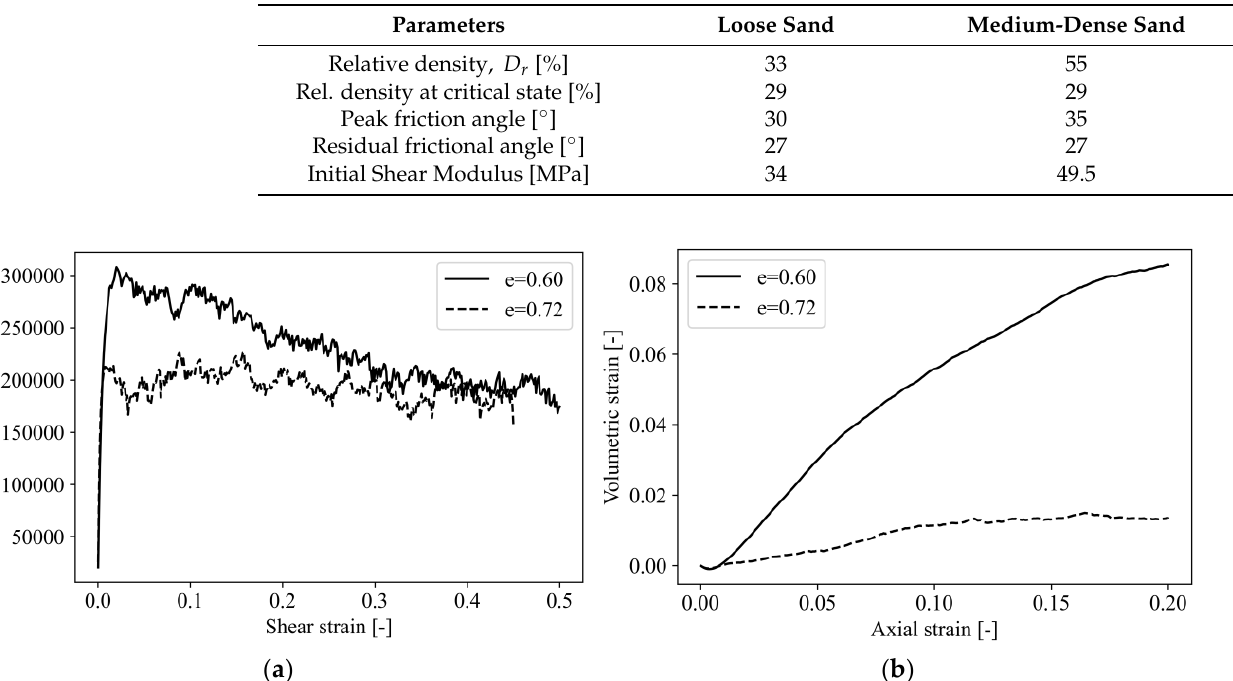
Table 2. Results of the monotonic triaxial testing.